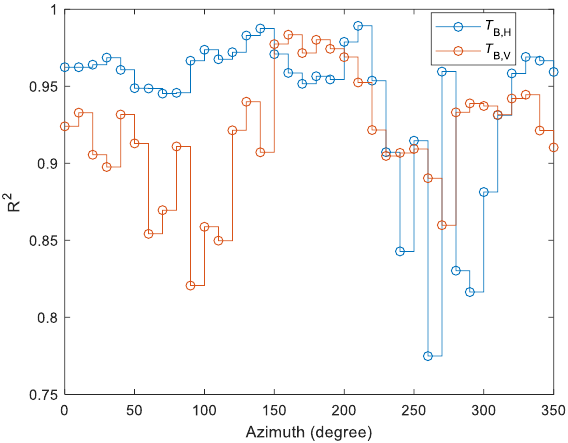
Figure 7. Azimuthally resolved R 2 values for measured (ELBARA) vs. estimated (L-band microwave emission of the biosphere simplified roughness parametrization—L-MEB SRP) brightness temperatures, at horizontal (H) and vertical (V) polarizations.